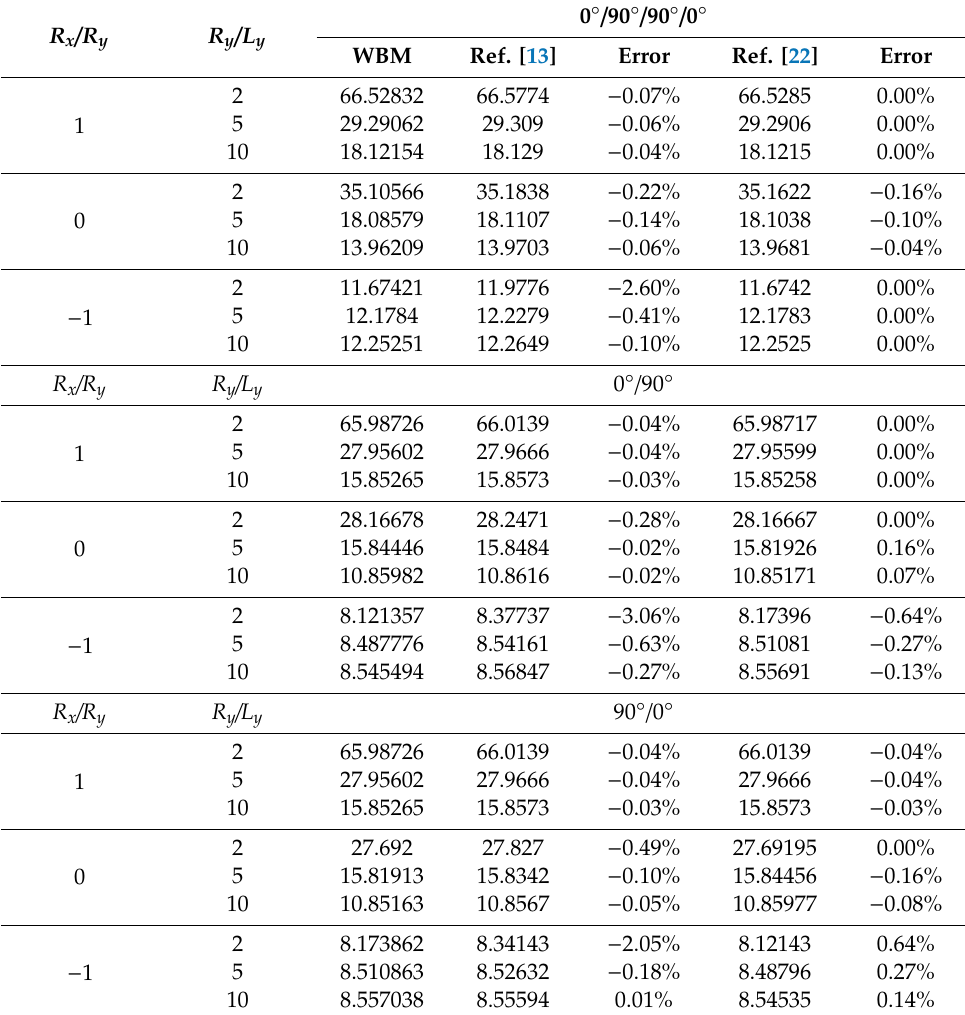
Table 2. The fundamental frequency parameter Ω for composite shallow shell with the SD-SD boundary condition by classical shell theory (CST) theory.